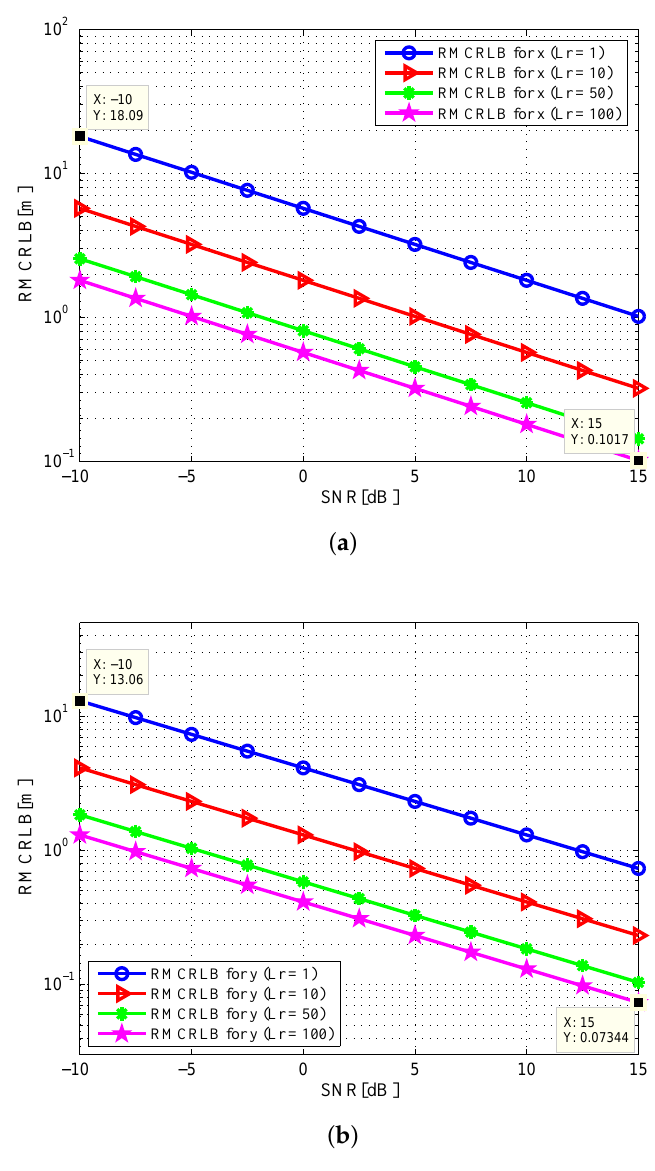
Figure 6. RMCRLB versus SNR in the target position dimensions with different L r when N = 1024 × 512: ( a ) x-position; ( b )